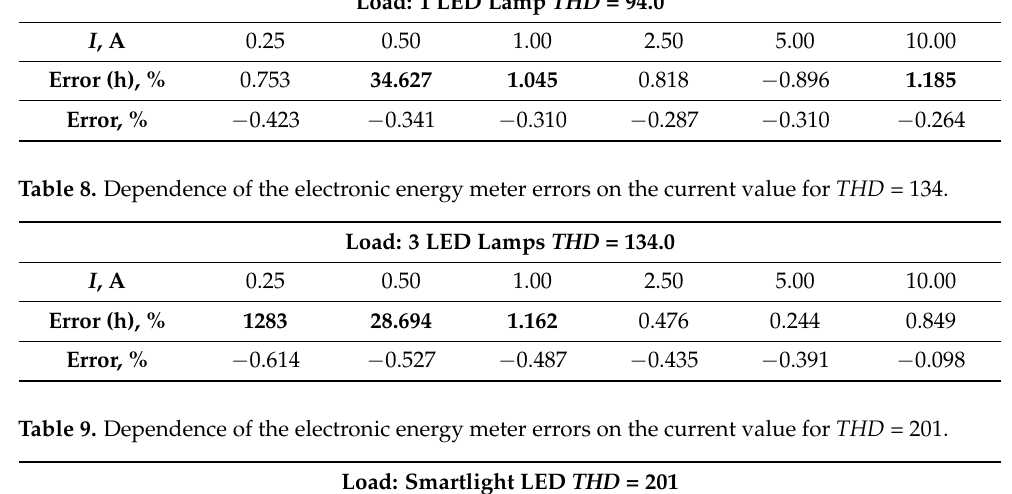
Table 7. Dependence of the electronic energy meter errors on the current value for THD = 94.0. Load: 1 LED Lamp THD = 94.0